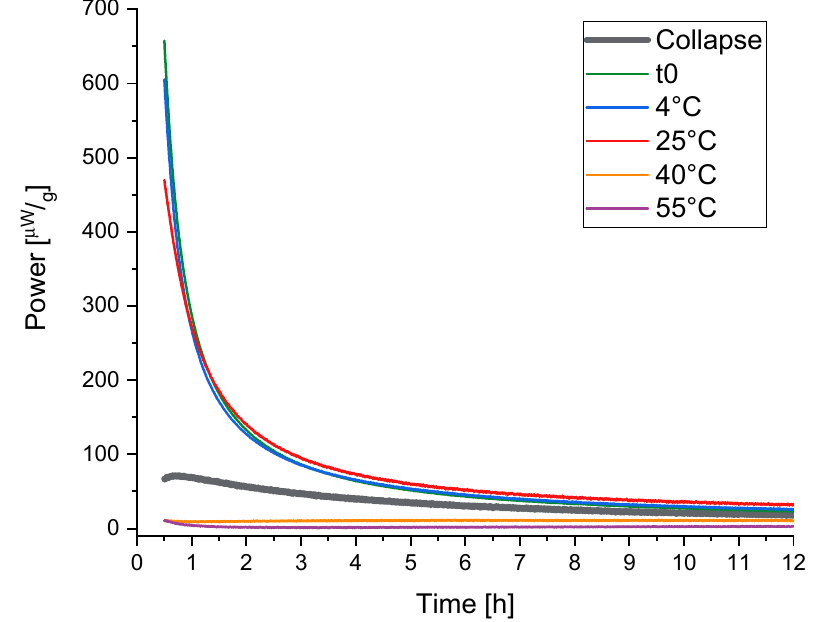
Figure 13. Comparison of the relaxation curve of the trehalose-based collapsed product with the curves of trehalose-based samples after conventional freeze-drying followed by tempering at different temperatures.